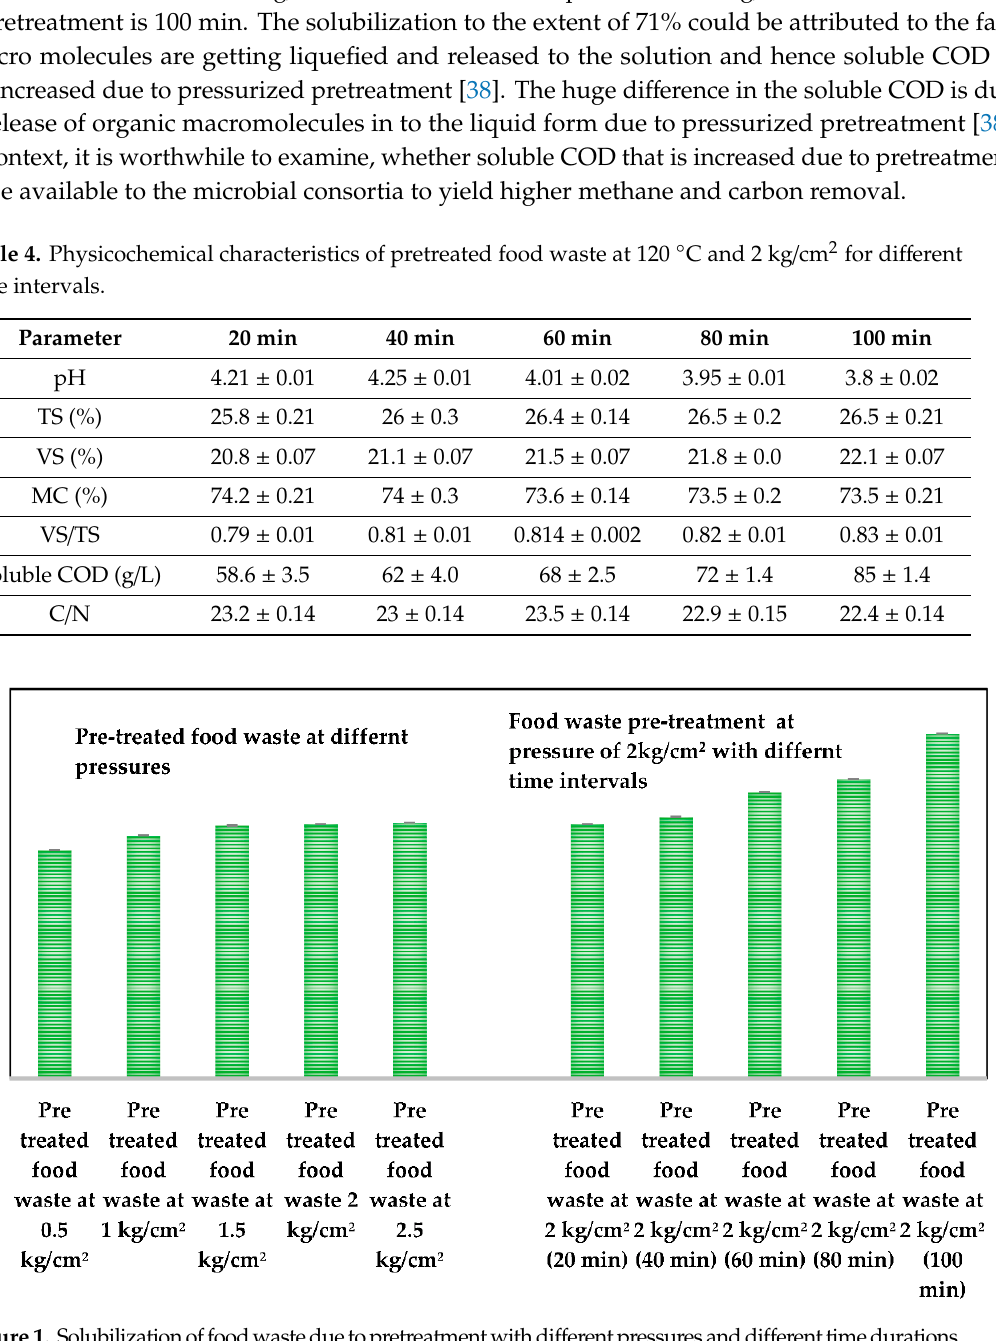
Figure 1. Figure 1. Solubilization of food waste due to pretreatment with different pressures and different time durations.